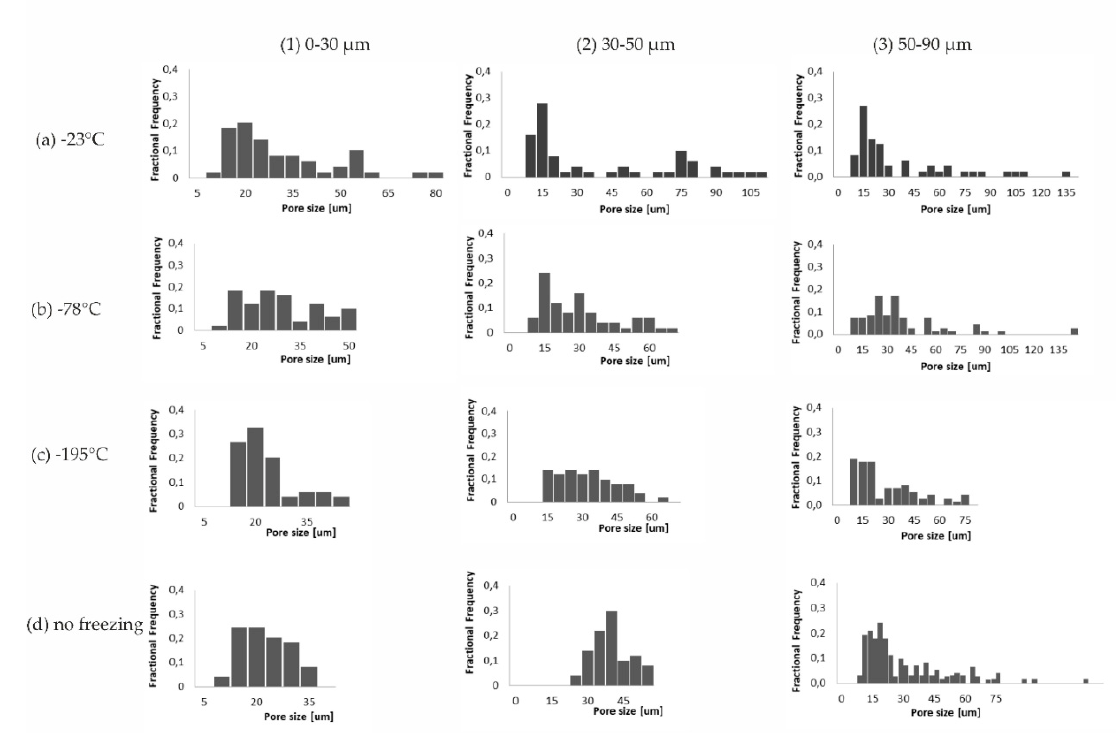
Figure 5. Fractional distribution of pore sizes in hydrogels. The pore size distribution suggests that the freezing method when applied before the morphological evaluation can influence the interpretation of the properties of the samples. It should be noted that the total pore number visually detected does not change depending on the freezing temperature, while the pore size as well as the gel wall thickness reveal some alterations. These changes in the pore sizes can be also tracked through the images (a–c) in Figure 1. There was significant development of large pores at the − 23 °C used freezing temperature in all three groups of gels. The pore sizes in the gels prepared under milder freezing conditions at least doubled compared with those gels frozen at the − 195 °C temperature or with the gels observed swollen in room temperature by LSCM. Pores between 15 and 25/30 µm in size represented a significant number of size fractions. This effect may be caused by the presence of “fine dust”, which was discovered during the analysis of porogen particles harvested after fractionation. The distribution of pore sizes in the samples prepared using liquid nitrogen (195 °C) obtained by SEM can be compared to those images acquired by LSCM. Indeed, the difference between the porogen size distribution and the porous structure seen in the images from LSCM documents the differences caused by the change in gel due to the hydrogel swelling. The gel volume increases as reaches its equilibrium swelling state. This process starts with the leaching process, when substances from the preparation phase—e.g., the porogen and additives—are removed and the sample is washed. We assumed that the volume change upon swelling is isotropic, therefore the pores also expanded isotropically, as is shown in Figure 1. A certain similarity of structures obtained by LSCM and SEM with a freezing temperature of − 195 °C was noticeable. However, the walls of the gels in the frozen samples were thinner compared with the walls of the gels in the equilibrium swollen state. The macroscopic volume of the samples was unchanged, which meant that the gel matrix volume change was compensated by the pore enlargement.